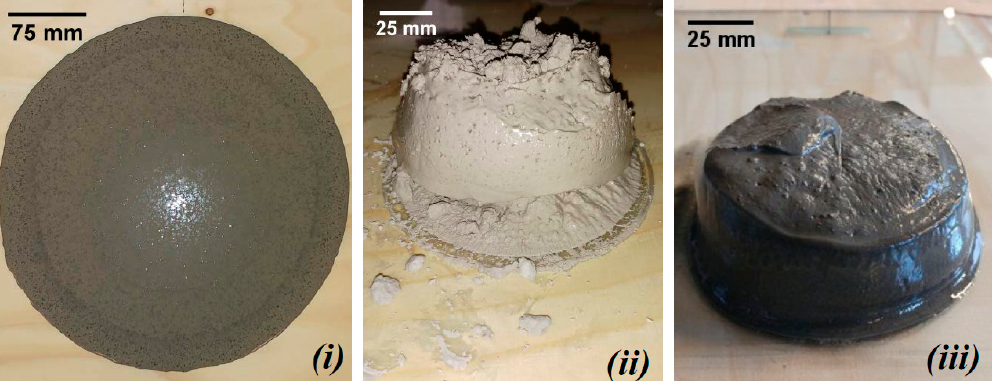
Figure 5. The mini-slump spread test for ( i ) S0 (alkali-activated FA paste), ( ii ) S100 (alkali-activated GBFS paste), and ( iii ) CEM I 42.5 N paste for l/b = 0.4.